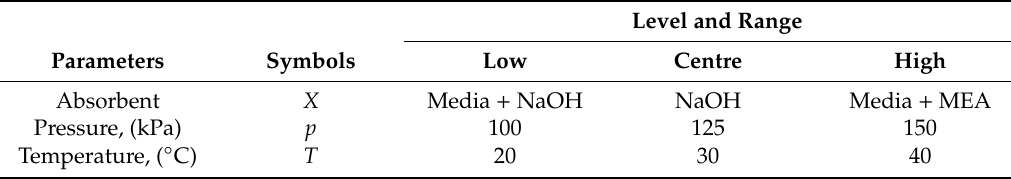
Table 1. Levels and ranges of independent input parameters in the Box-Behnken